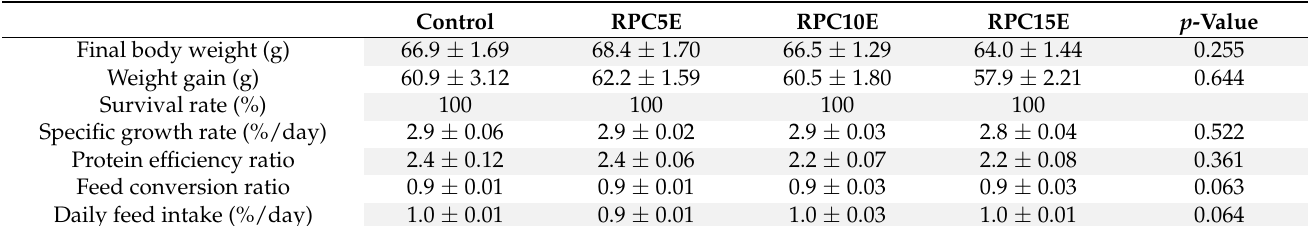
Table 4. Growth performance of rainbow trout juveniles after 12 weeks.